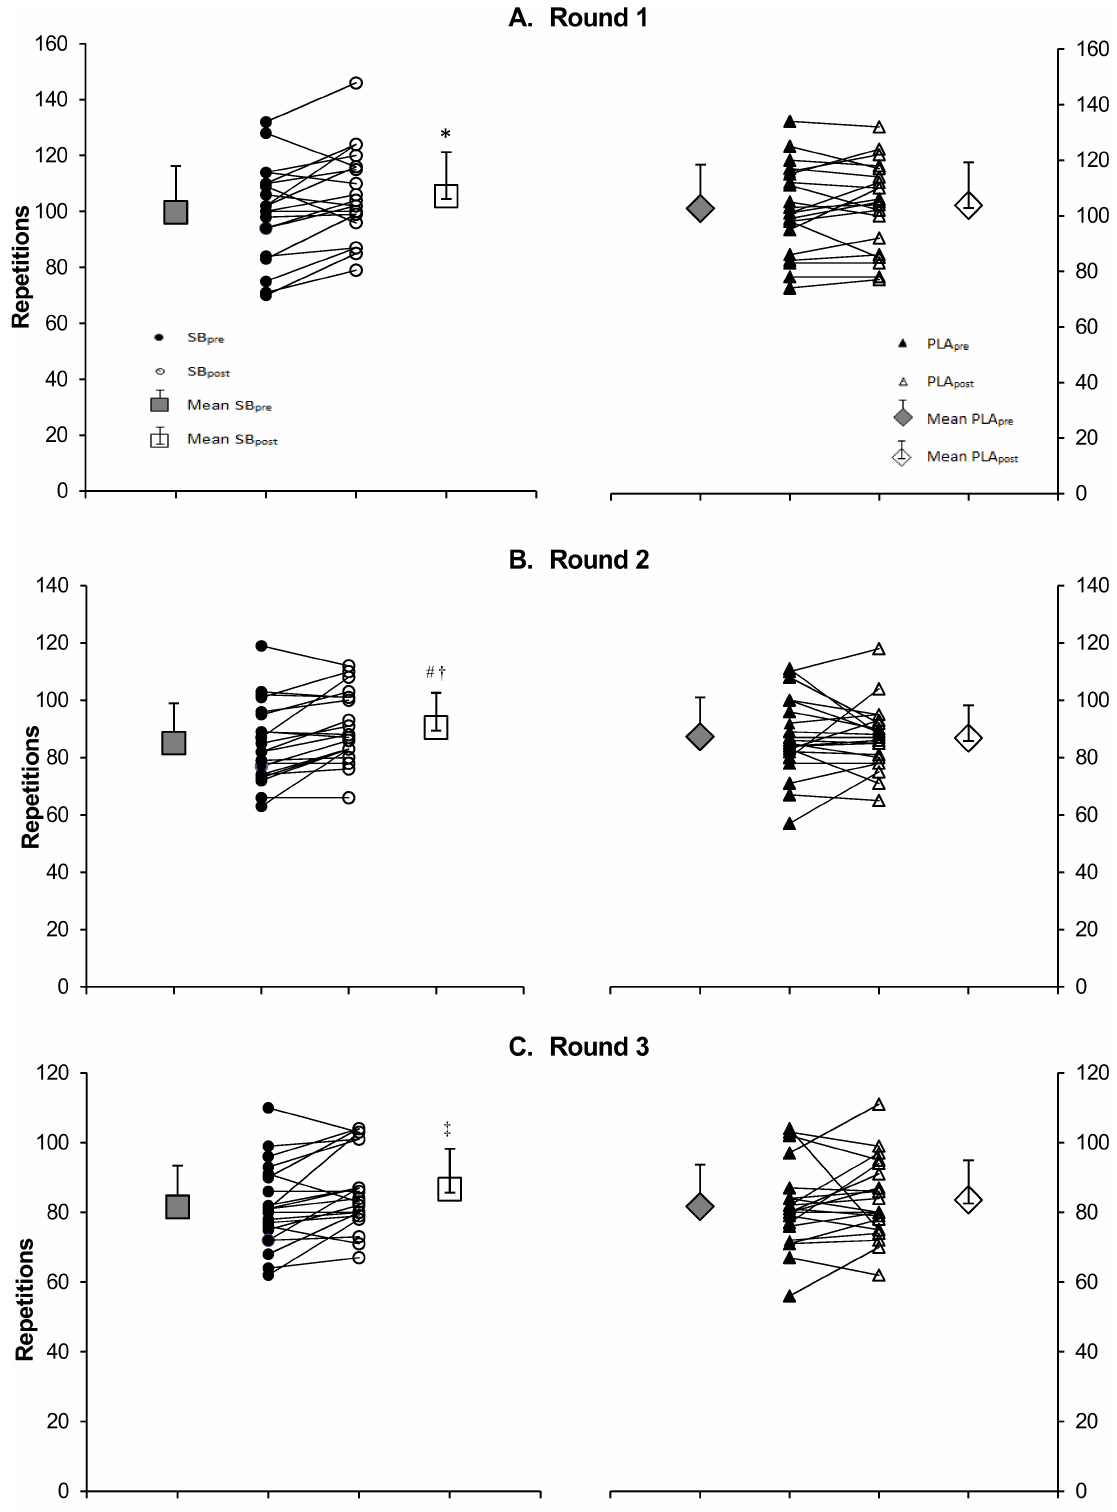
Fig 2. Performance in each Fight Gone Bad round. Panel A—repetitions completed in round 1, panel B—repetitions completed in round 2 and panel C—repetitions completed in round 3. SB pre , before sodium bicarbonate trial; SB post , after sodium bicarbonate trial; PLA pre ,